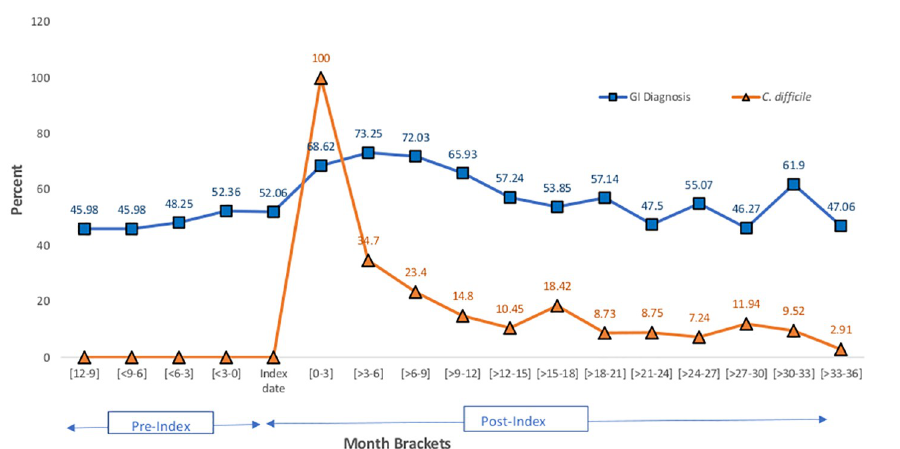
Fig 3. Prevalence of gastrointestinal (GI) diagnoses and Clostridium difficile diagnosis per person-admission at baseline and